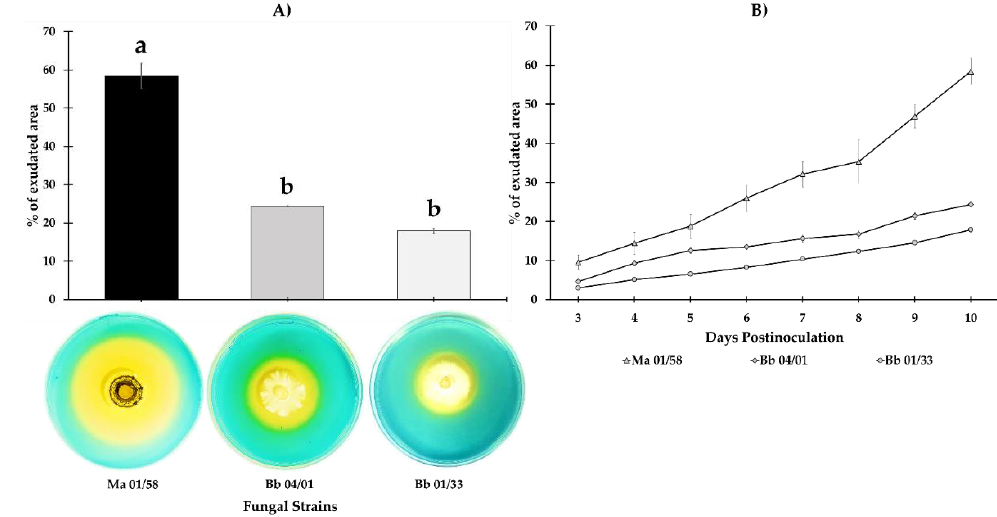
Figure 1. Siderophore exudation by three isolates of IPF on CAS agar medium with FeCl 3 as FeIII source. At the bottom, the front of plates is shown. ( A ) Comparison at 10 days post inoculation (dpi). Bars with different letters are significantly different to each other according to Tukey test ( p < 0.05). ( B ) Progress (%) of colour change due to siderophore production by three isolates of IPF on CAS agar medium.